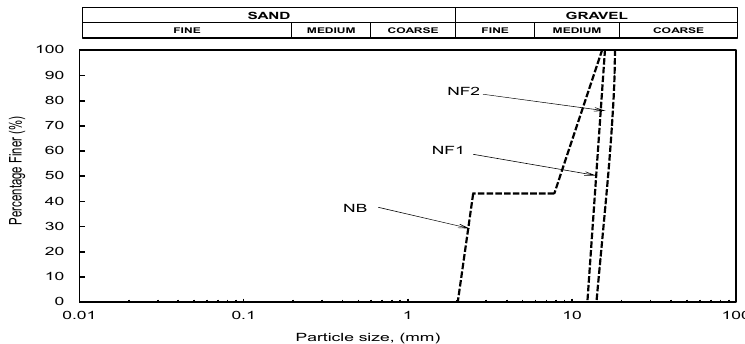
Water 2021 , 13 , x FOR PEER REVIEW Figure 1. Current base and filter soil gradations simulated in this study. Figure 1. Current base and filter soil gradations simulated in this study.